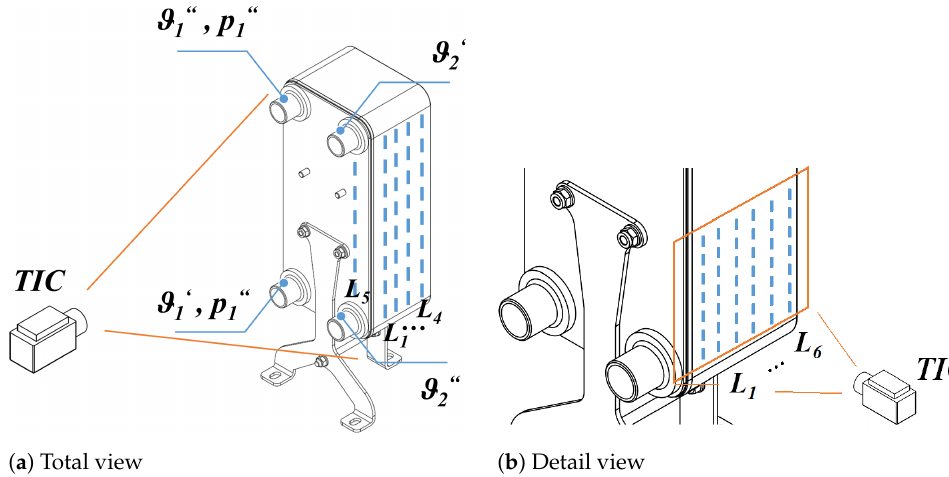
Figure 3. Experimental set-up to observe the reversible HP-condenser/ORC-evaporator with a thermal imaging camera (TIC) during